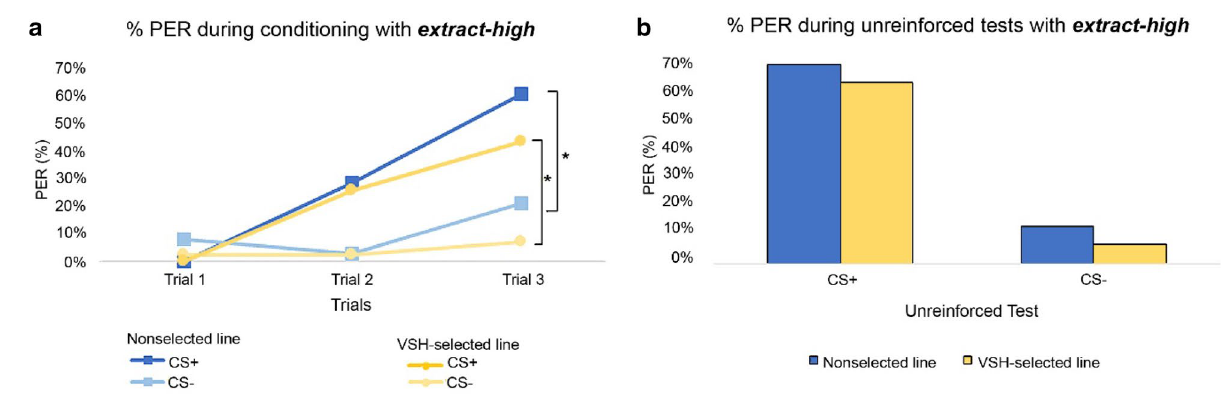
Figure 2. Drone performance during PER-conditioning experiment with extract-high . Acquisition ( a ) and results from the unreinforced tests ( b ) are shown for both stimuli (CS+ and CS−) and origins (nonselected line, VSH-selected line). The curves display the behavioural reaction—proboscis extension—for the reinforced (CS+) and the non-reinforced (CS−) stimulus. The bars show the behavioural reaction during the unreinforced tests with both stimuli. A total of 202 drones were tested using extract-high . The stimulus effect (reinforced, non- reinforced) was significant—(*) p <